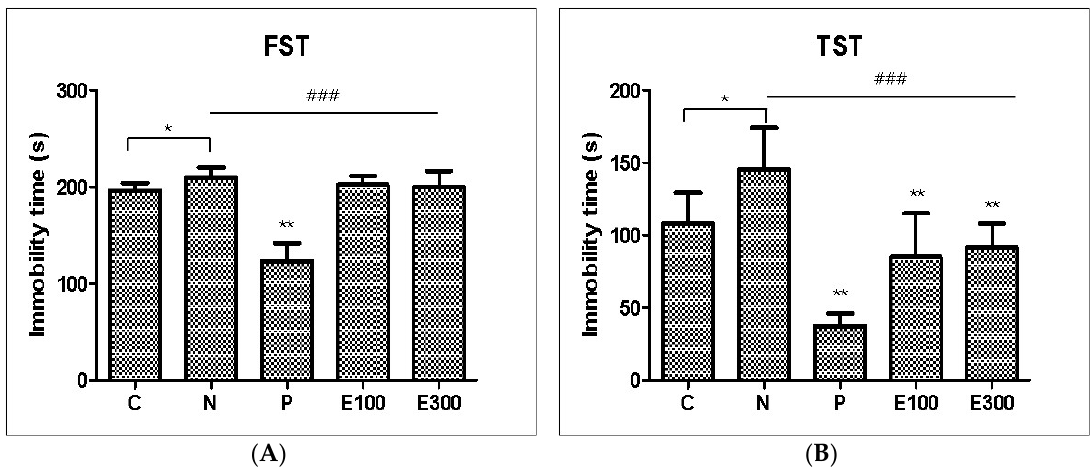
Figure 2. Behavioral analyses of the forced swimming test (FST) ( A ) and tail-suspension test (TST) ( B ) after intraperitoneal injection of fluoxetine and oral administration of the extract into mice ( n = 7). C: normal control; N: negative control (chronic unpredictable mild stress (CUMS)); P: positive control (CUMS + 15 mg/kg fluoxetine); E100 and E300: doses of the extract (CUMS + 100 and 300 mg/kg, respectively). #: Kruskal-Wallis test; *: Mann-Whitney test. ###: p < 0.001; *: p < 0.05; **: p < 0.01.